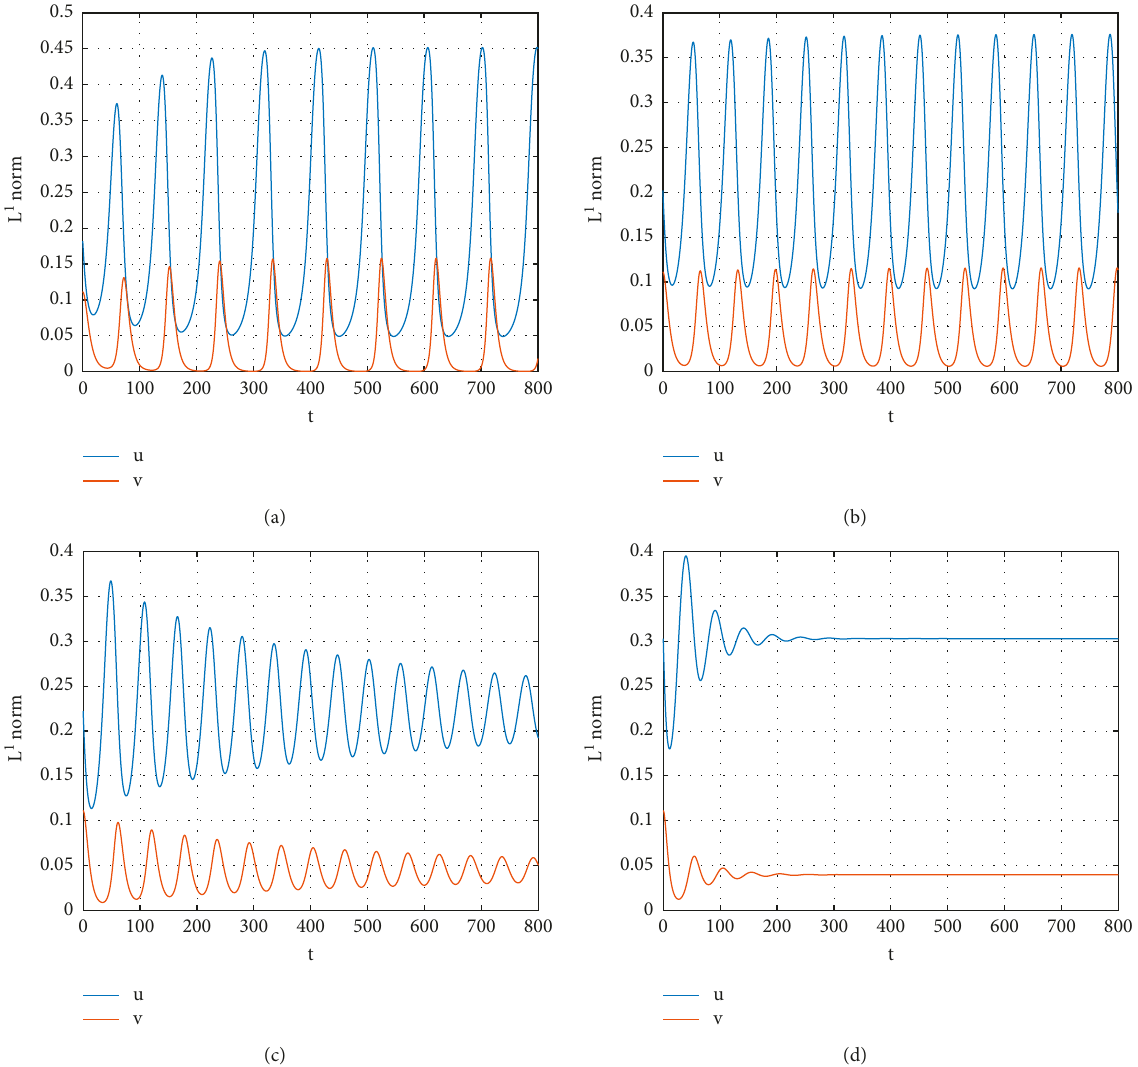
Figure 3: The effects of parameter d for T � 800 , l � 2. The values of parameter d are as follows: (a) d � 0 . 18; (b) d � 0 . 2; (c) d � 0 . 22; (d) d � 0 .